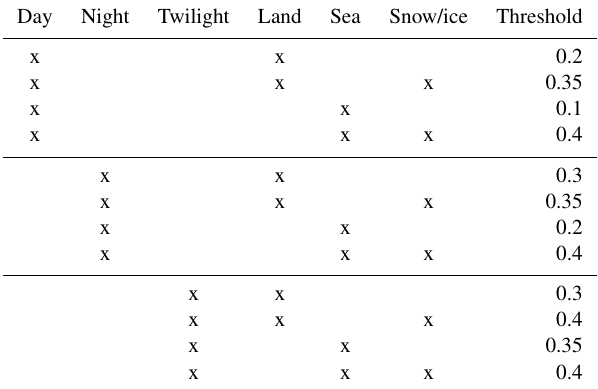
Table 2. Threshold values applied to ANNCOD data for cloud mask